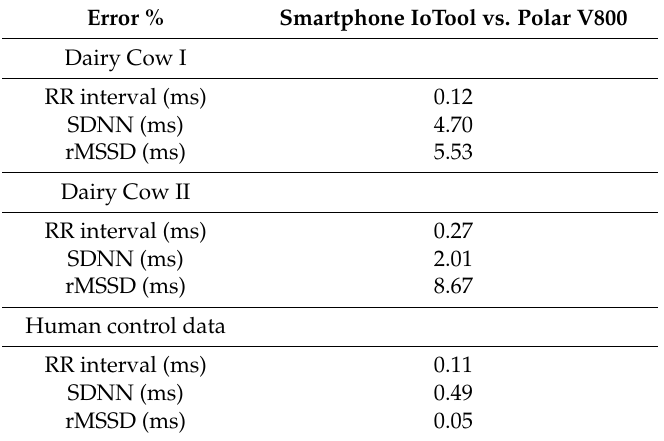
Table 2. Percentage relative errors of heart rate variability (HRV) parameter